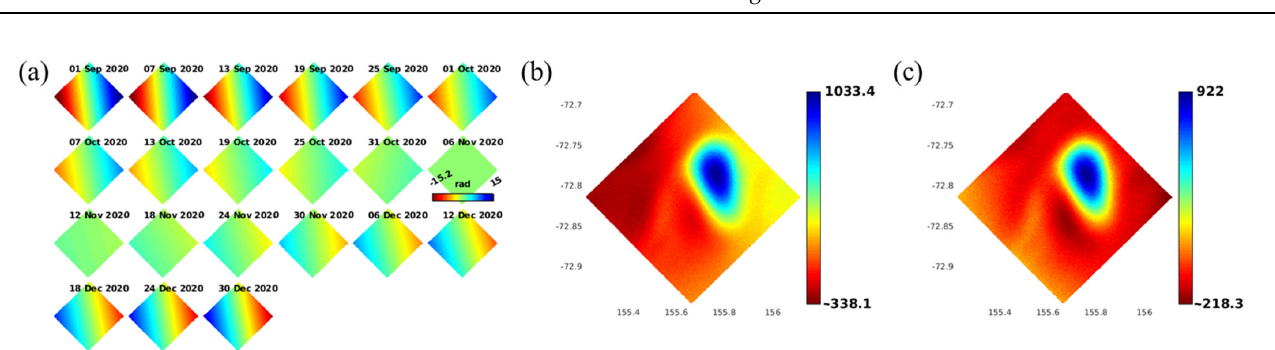
Figure 6. Example images of orbital ramp removal: ( a ) time-series images of orbital ramps calculated in PSInSAR processing from September to December 2020; ( b ) the image before orbital ramps removal; and ( c ) the image after orbital ramps removal.